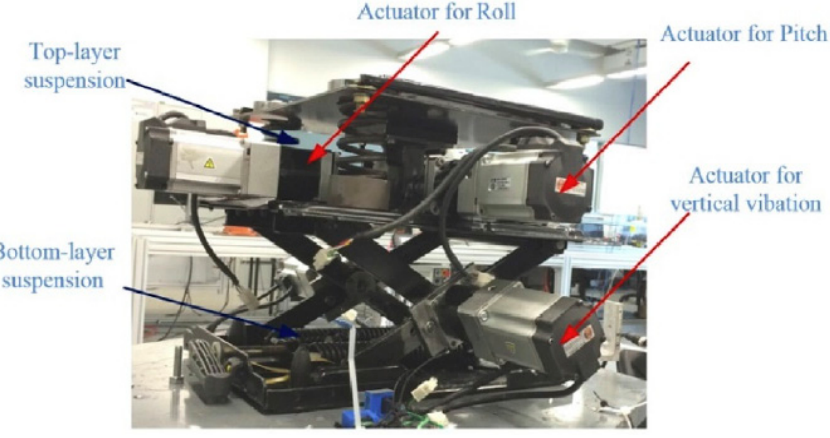
Figure 5. Multiple DOF active seating suspension system [49].